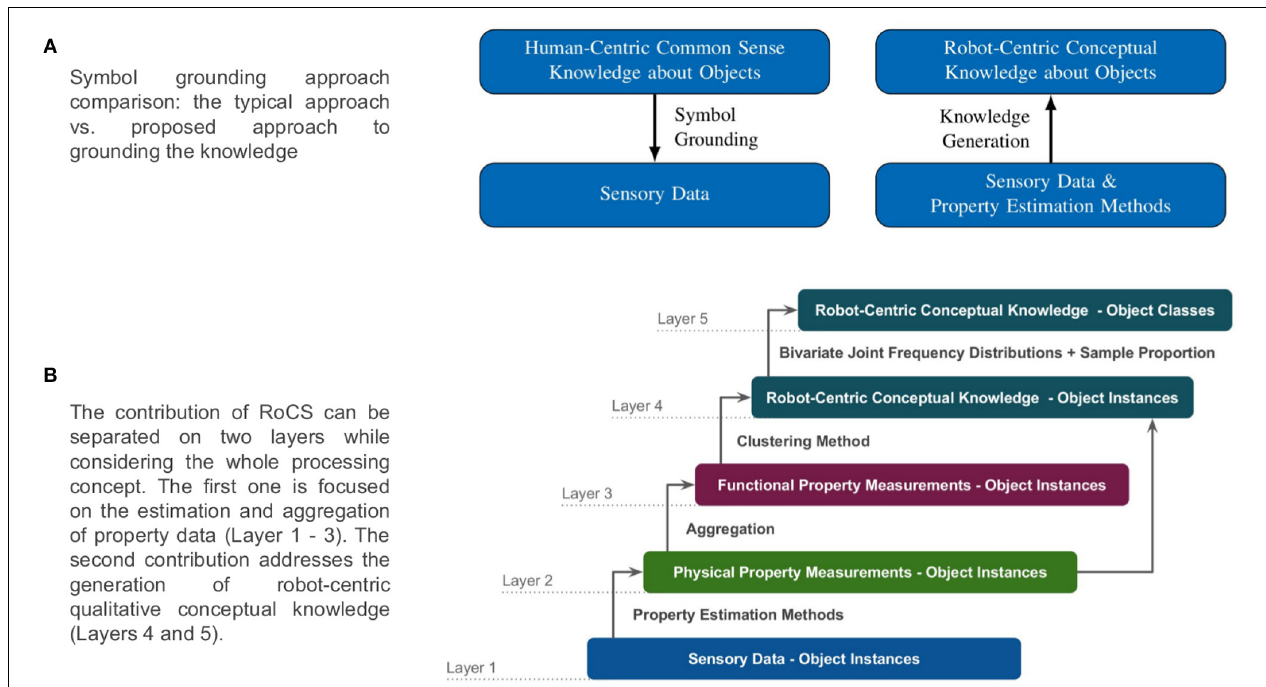
FIGURE 2 | (A) represents our symbol grounding approach while figure (B) illustrates the process layers for our bottom-up robot-centric knowledge generation.